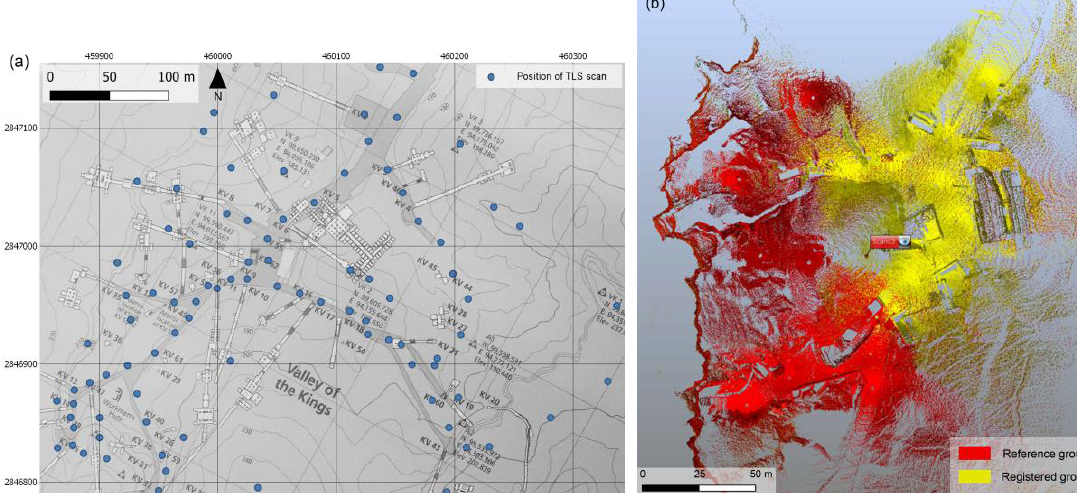
Figure 2. Laser scanning survey: ( a ) position of each of the acquired TLS scans (blue dots), superimposed to the Sheet 1 / 70, KV and WV extracted from the Atlas of the TMP, page 13, Plan 1:2500, Contour interval 10 m. ( b ) The registration process of the scans groups performed via the software Faro SCENE.